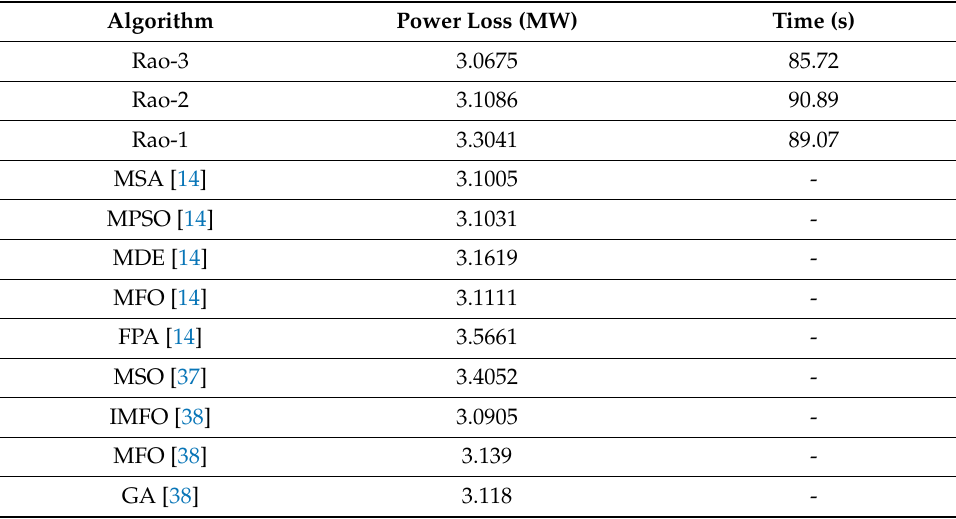
Figure 4. Convergence characteristics for the IEEE 30-bus system, Case 5. Table 8. Case 5: RPLM in the IEEE 30-bus system.